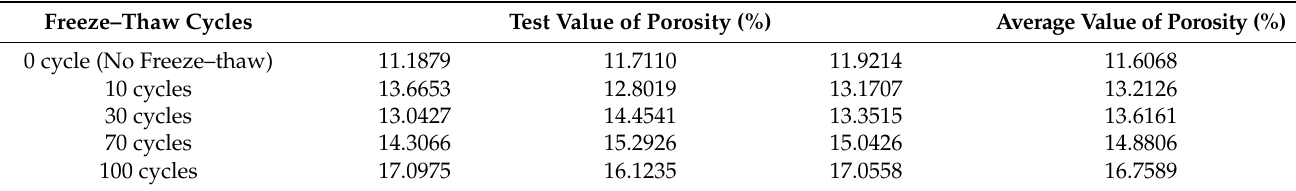
Table 2. Porosity of red sandstone.